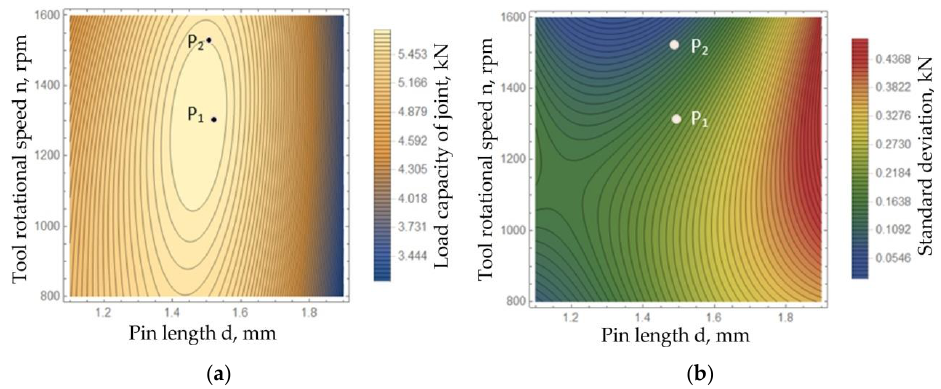
Figure 19. Solution of the problem of multi-criteria optimisation for a welding speed of x 2 = 200 mm/min: ( a ) contour plot of the regression function of load capacity of joint, ( b ) contour plot of the regression function of the standard deviation of the results.